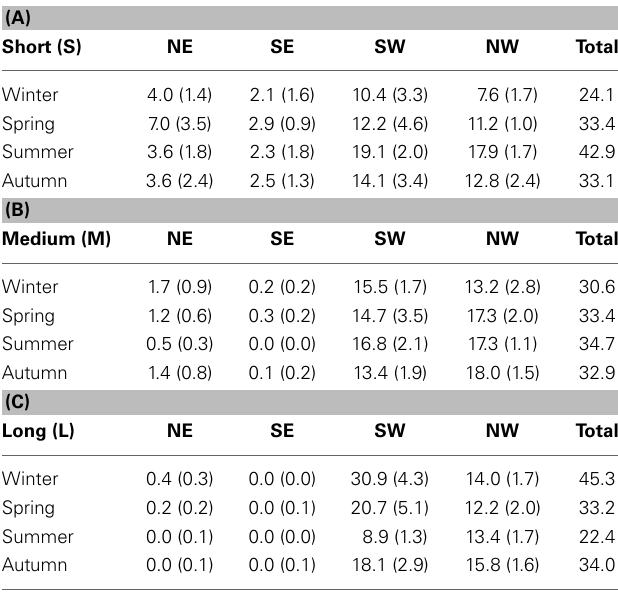
Table 4 | Mean frequencies (%) of occurrence of the different classes for category Distance and Origin (DO) and the respective standard deviation (%) in